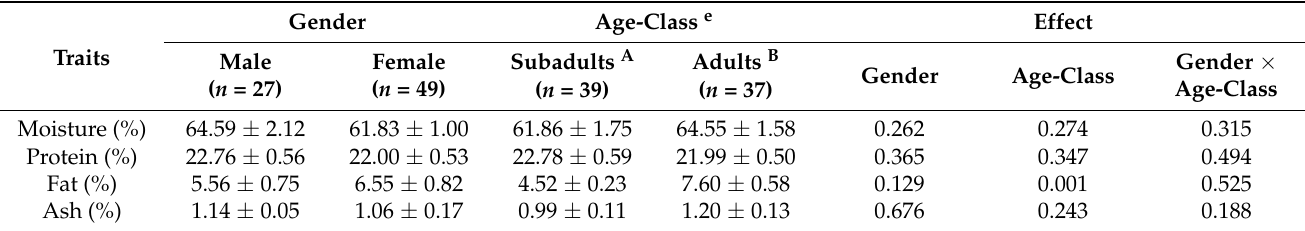
Table 3. Chemical composition (mean ± SEM) of Biceps femoris muscle from wild boars hunted in